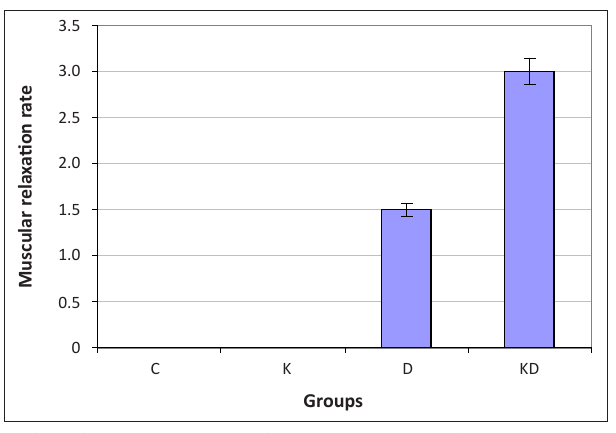
FIGURE 1: The comparison of muscular relaxation across the groups of pigeons treated with normal saline, ketamine, diazepam, and a ketamine and diazepam combination, where a score of 0.0 represents weak relaxation, 1.5 represents moderate relaxation and 3.0 represents excellent